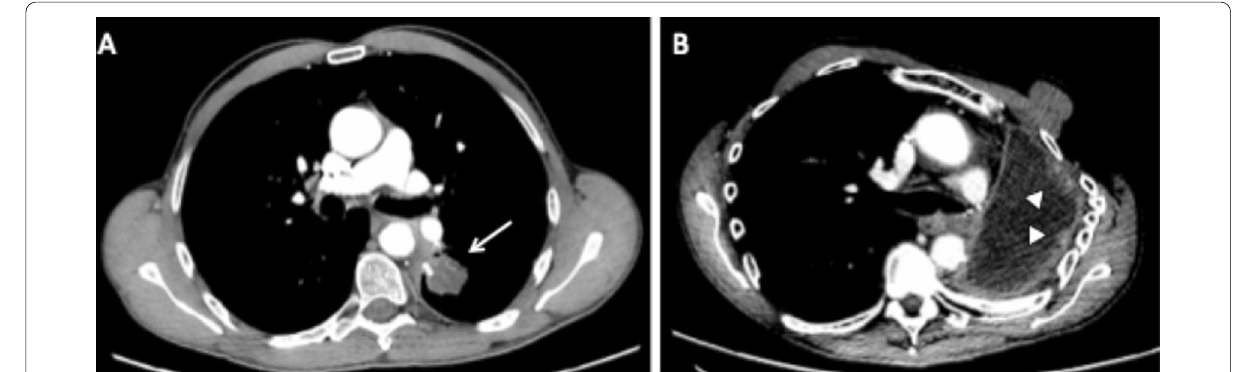
Fig. 18 Local tumour recurrence. A : Axial CT image (mediastinal window) showing a tumour recurrence on a staple line from a left lower lobe wedge resection (white arrow). B Axial CT image (mediastinal window) showing a tumour recurrence on the pleura after left pneumonectomy (white arrowheads), 1 year after